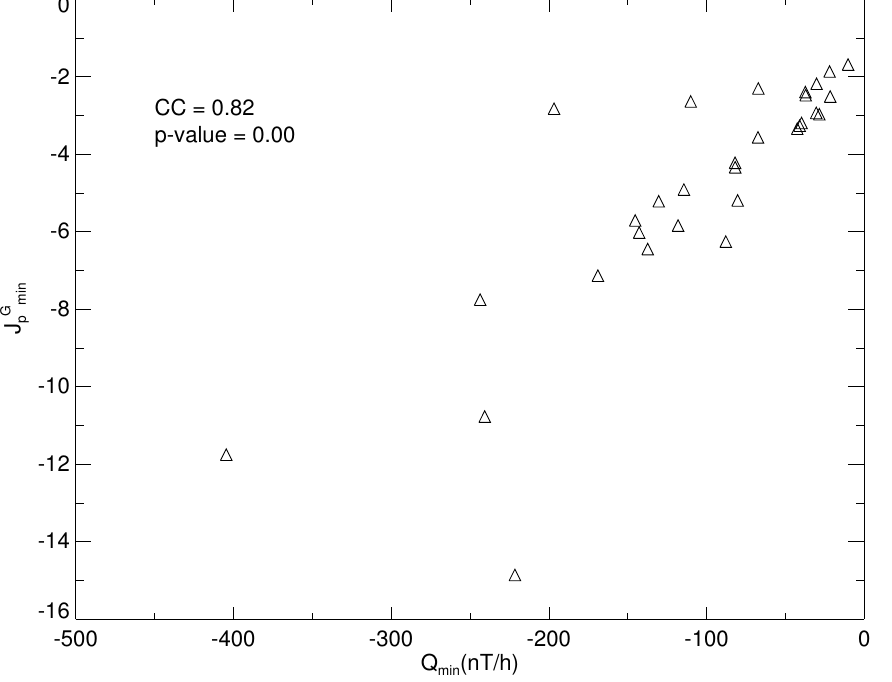
Figure 7. Correlation between Q minimum and J G p minimum for 30 great magnetic storm events from 1998 to